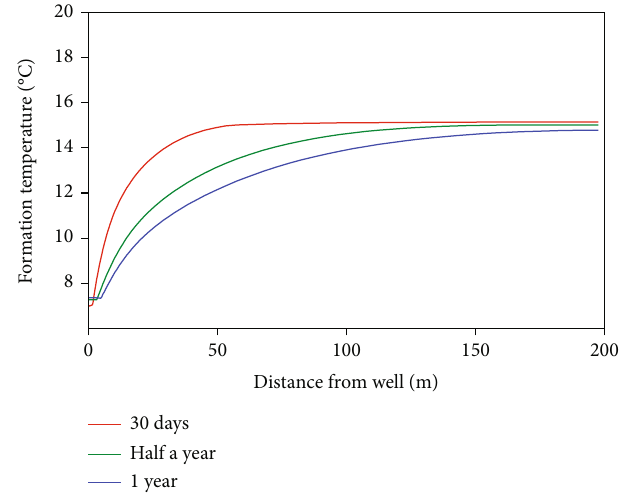
Figure 13: The distributions of temperature at di ff erent times.